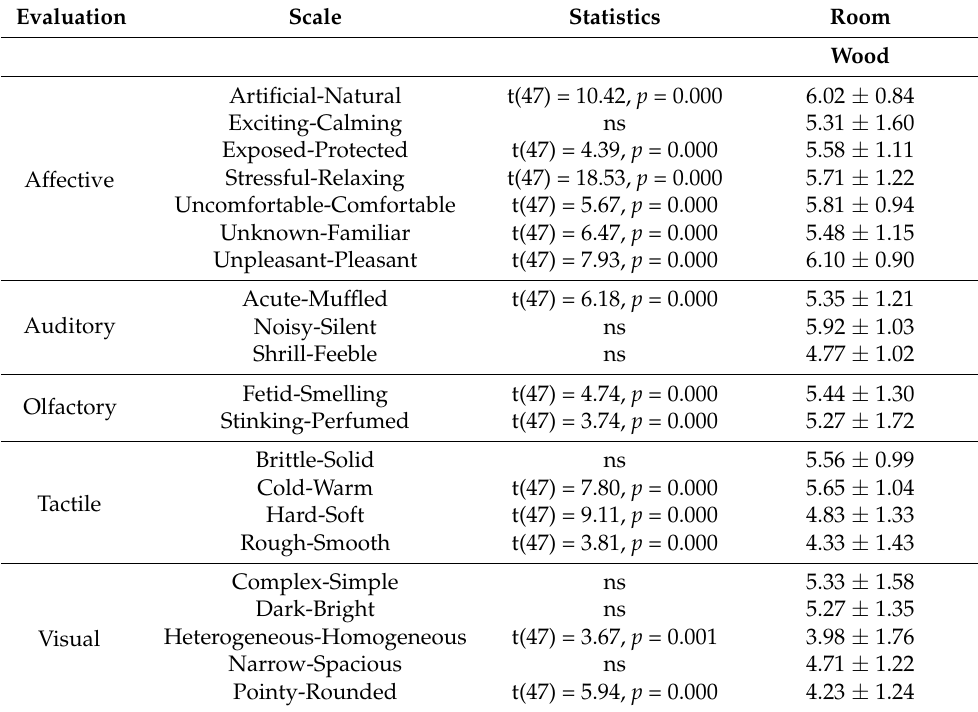
Table 3. Results of rooms evaluation using semantic differential questionnaire (ns: non-